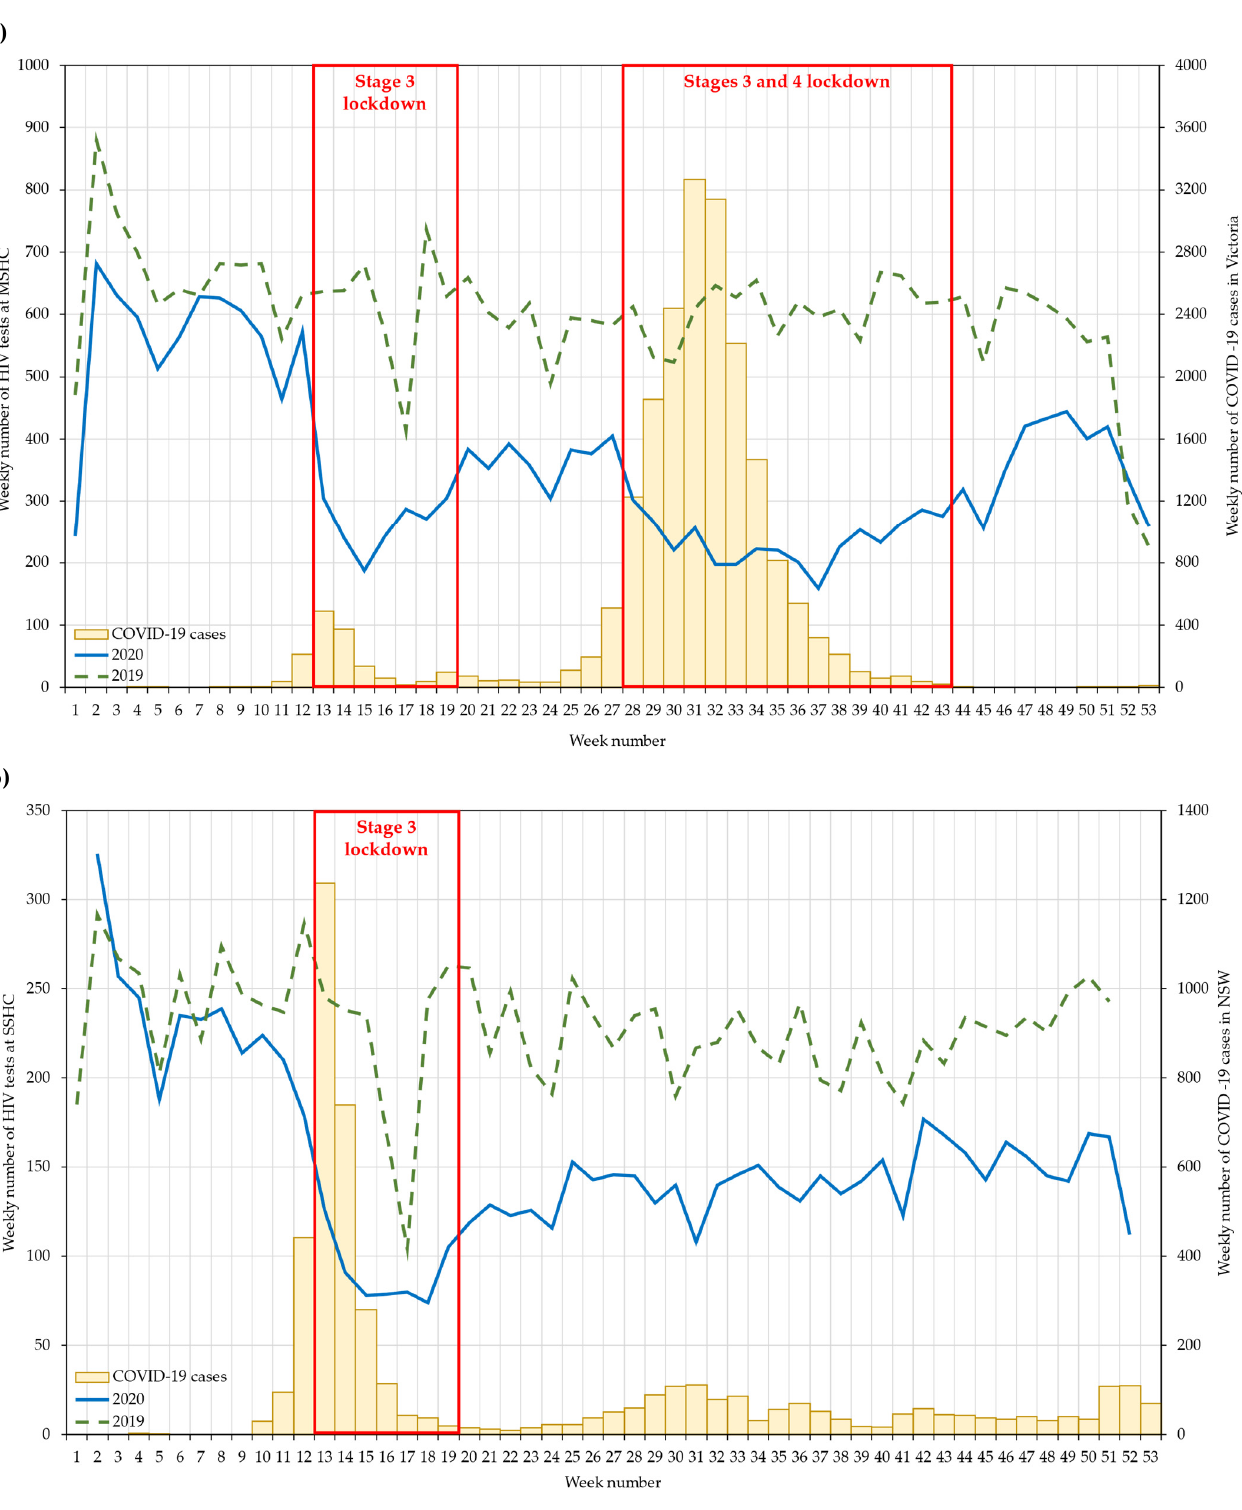
Figure 3. Weekly number of HIV tests at the ( a ) Melbourne Sexual Health Centre and ( b ) Sydney Sexual Health Centre, in 2019–2020. Data were not available in 2019 weeks 52 and 53, and 2020 weeks 1 and 53 at the Sydney Sexual Health Centre due to closure over Christmas and New Year. Stage 3 lockdown included social-distancing rules, stay-at-home orders, and closure of non-essential businesses. Stage 4 lockdown included Stage 3 lockdown measures in addition to a curfew (8 pm–5 am) and a 5 km travel limit.